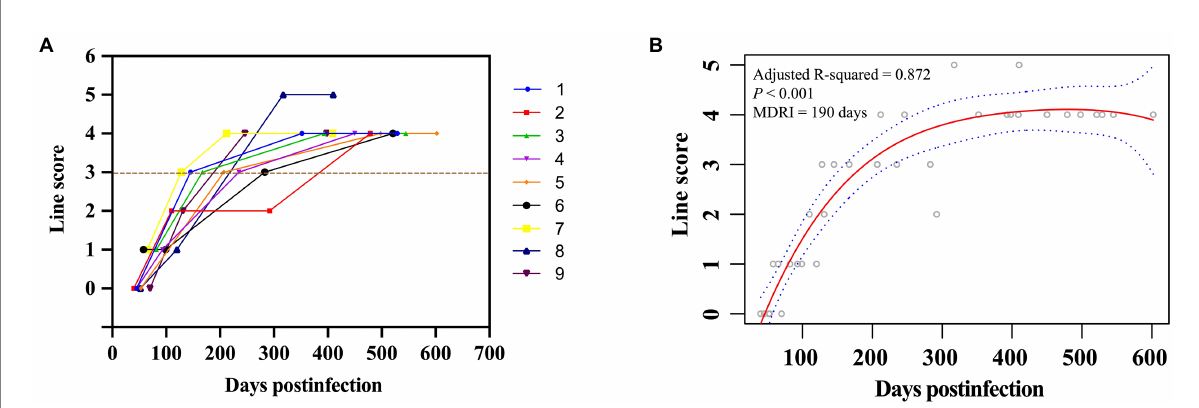
FIGURE 2 Discrimination of HIV-1 recent and long-term infection using rapid recent-infection testing strip in longitudinal cohort samples. (A) A total of 36 longitudinal seroconversion samples collected from 9 HIV-1-infected individuals were labeled with different colors and detected by rapid recent- infection testing strip (RRITS) at different time points. Y axis shows T 1 line score of RRITS, which is determined according to the density of T 1 line. The brown dash line represents the cut-off value of T 1 line of RRITS. (B) The relationship between the time post-infection and the line score of T 1 through polynomial regression analysis. The polynomial regression values and their 95% confidence intervals are presented in red solid line and blue curves, respectively. MDRI, mean duration of recent